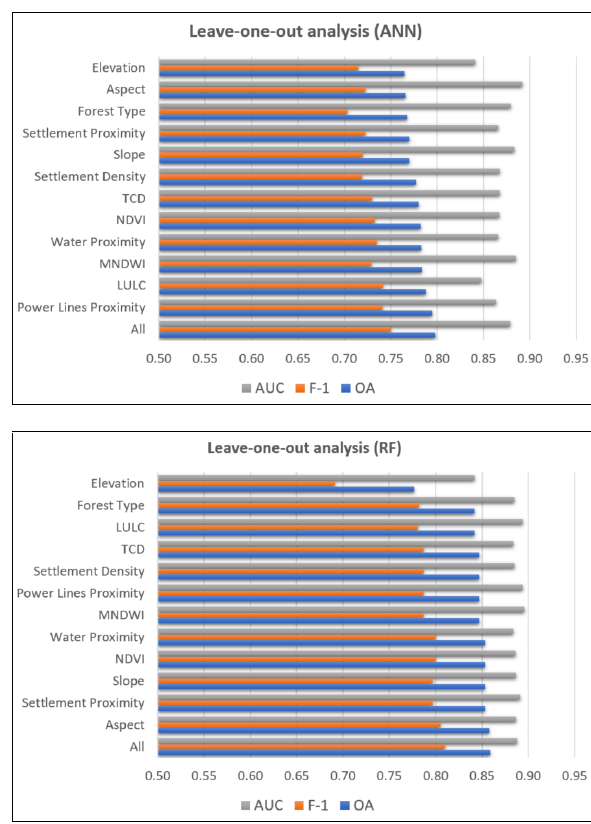
Figure 9. Leave-one-out analysis results ordered by OA values. When the results presented here are compared with the study of Kantarcioglu et al. (2023) carried out in Thrace